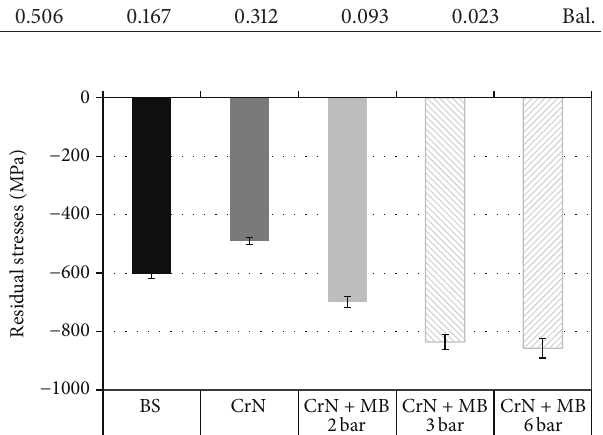
Figure 1: Residual stress measurements in the steel